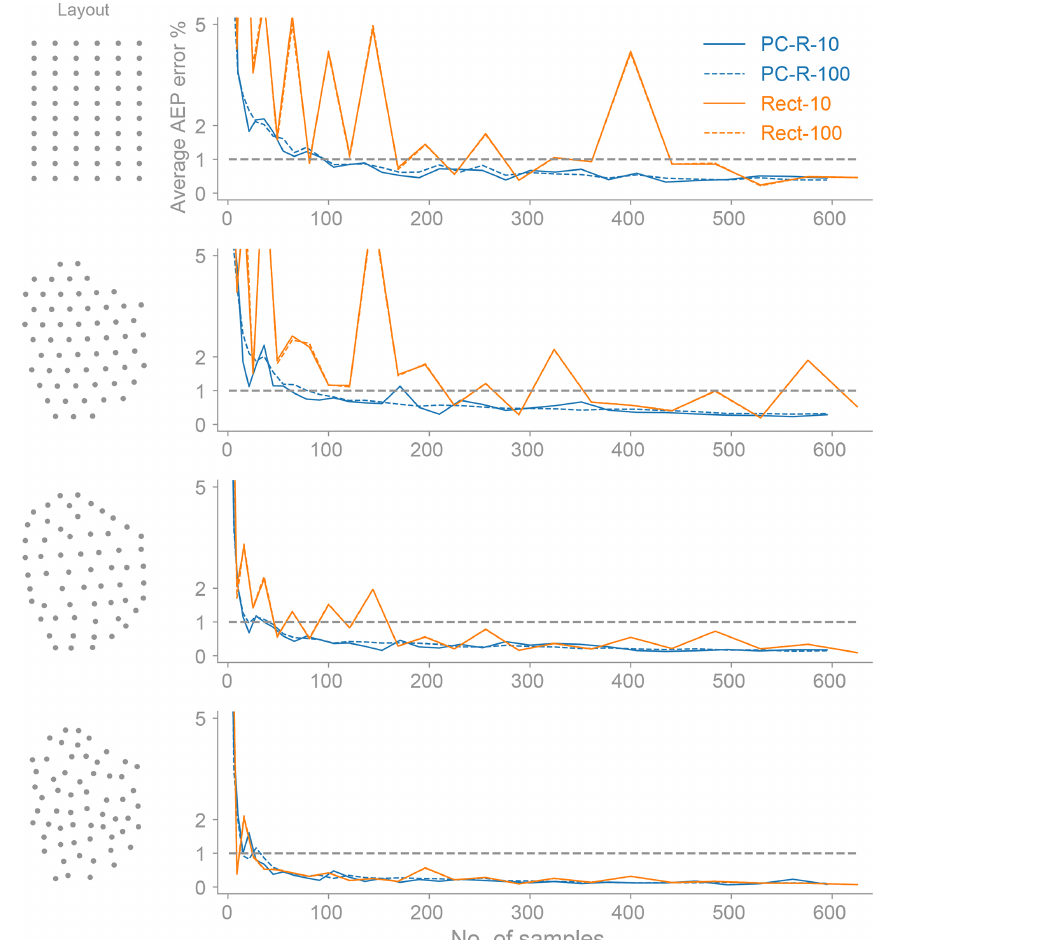
Figure 8. The average AEP error as a function of the number of samples for both the rectangle rule and polynomial chaos based on regression (this is the same as Fig. 6, with only keeping the PC-R and the rectangle rule results). In addition, we show the average AEP error computed with 10 (solid line) and 100 (dashed line) sets of samples (Sect. 5.3). The AEP is a function of two uncertain variables: the wind direction and wind speed. The polynomial chaos method computes the AEP more accurately with fewer samples.